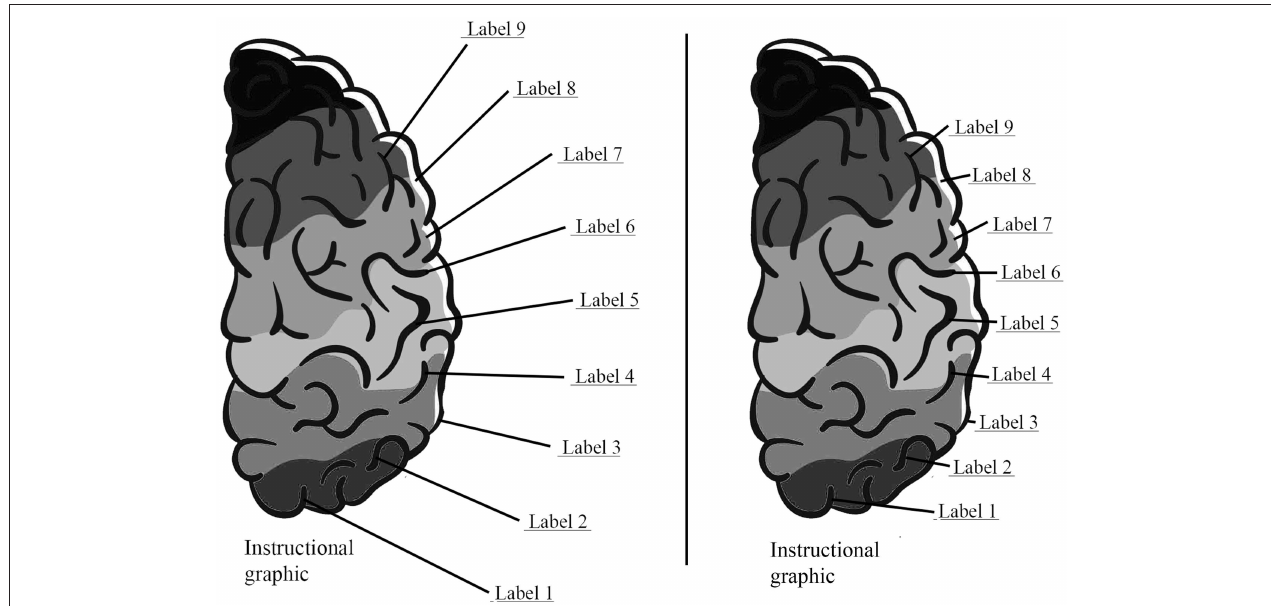
FIGURE 1 | A high distance between labels and the graphic leads to a higher distance between the labels (Left) and a low distance between the graphic and the labels leads to a high proximity between the labels (Right)